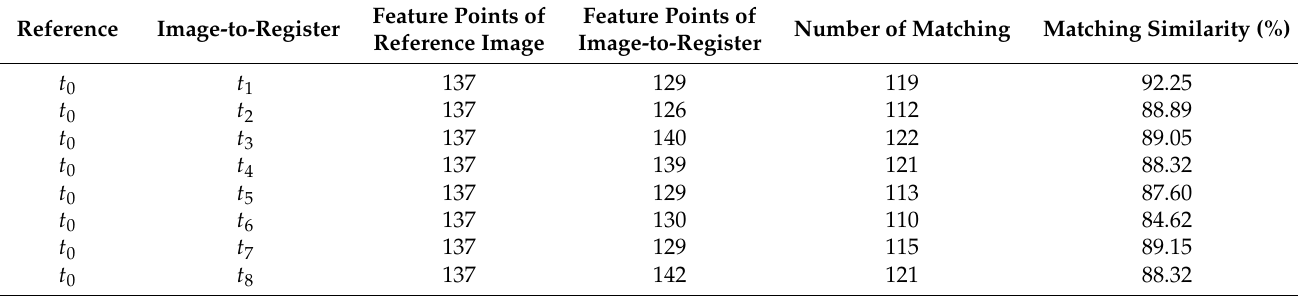
Table 2. Similarity of feature points matching between sequence image to be registered and fixed reference image.